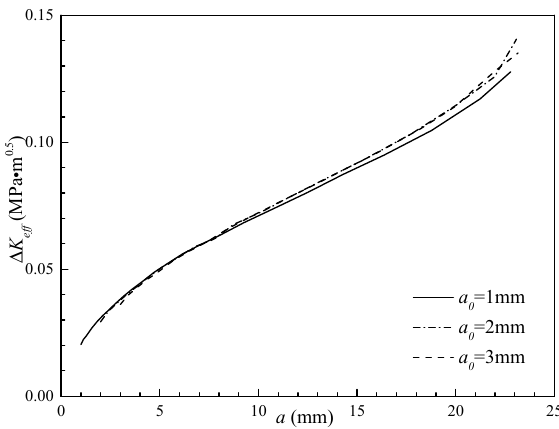
∆ K eff and crack length a